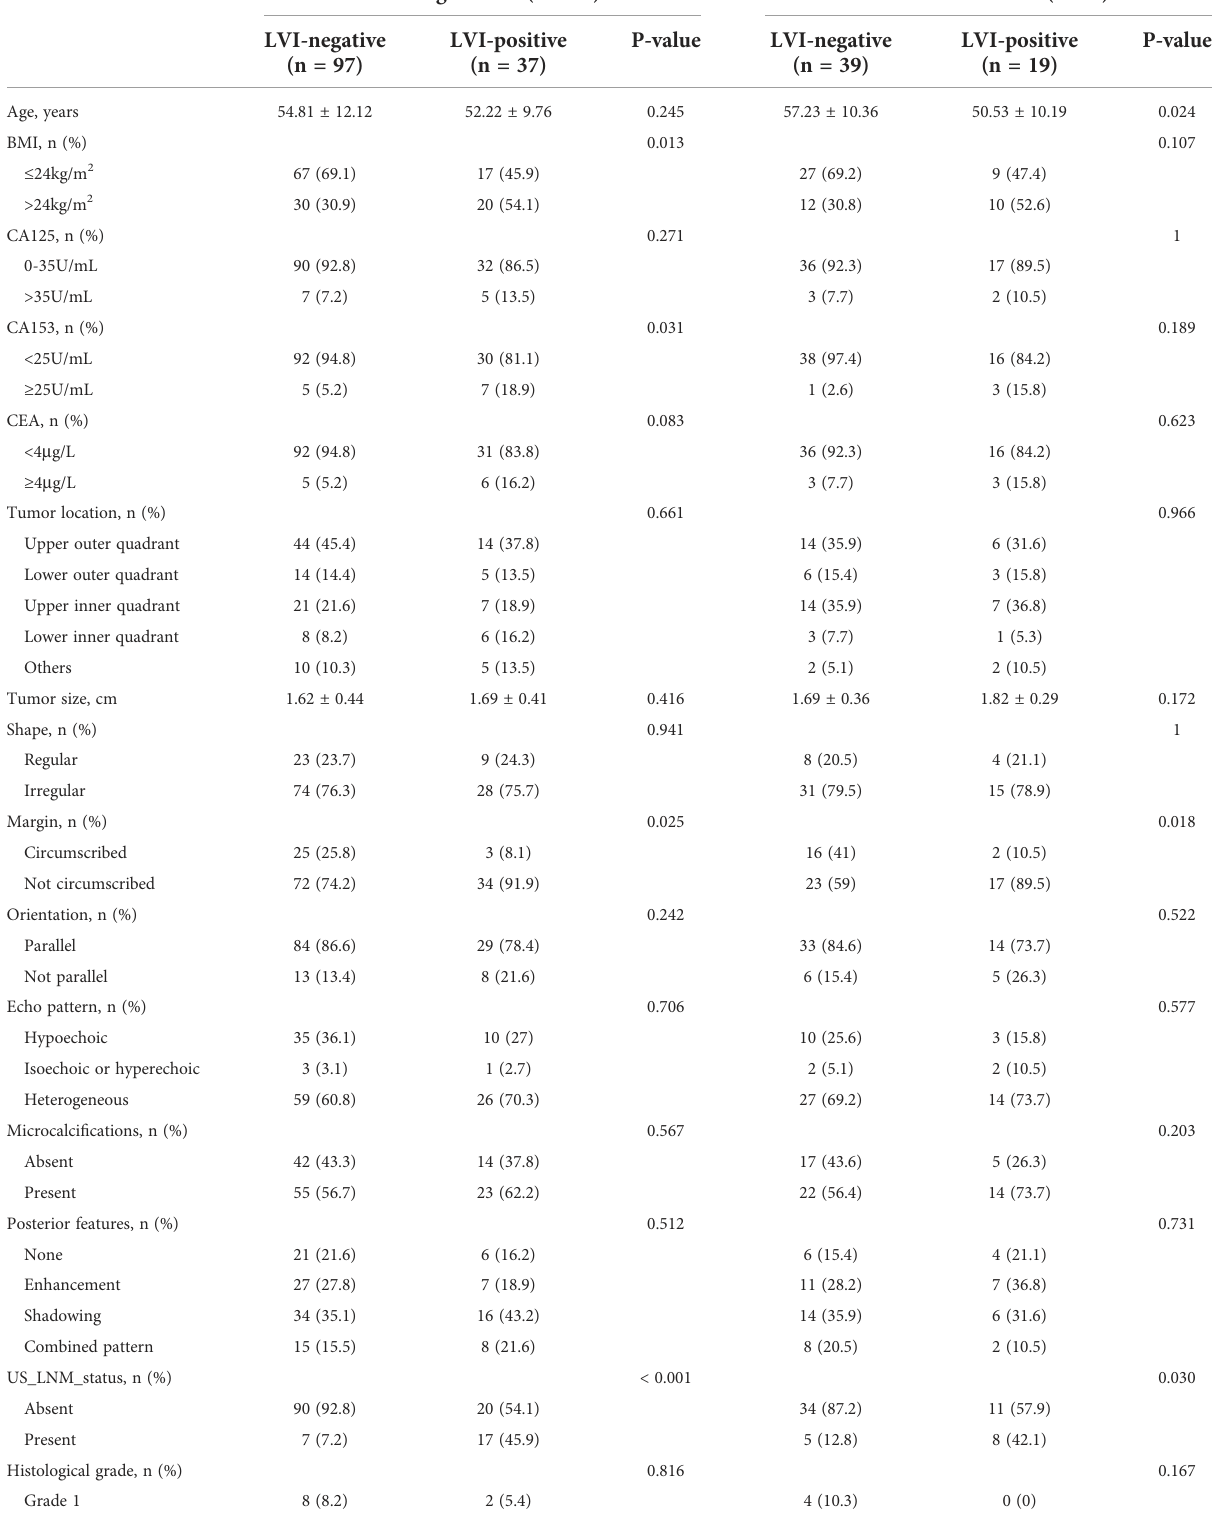
TABLE 4 Comparisons of baseline characteristics between LVI-positive and LVI-negative groups in the training and validation